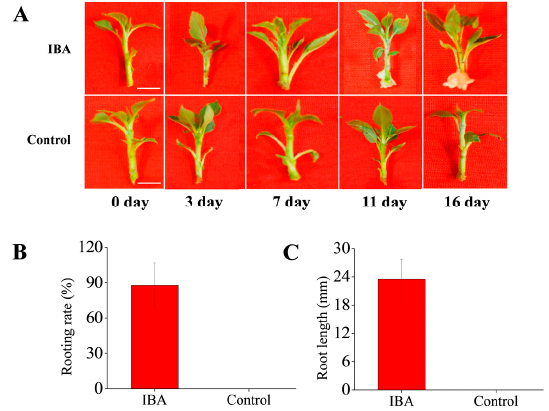
Figure 1. Effects of indole-3-butyric acid (IBA) on adventitious root formation in apple rootstock ‘T337’. ( A ) Morphological changes in ‘T337’ cultural cuttings after treatment with IBA and control for 0, 3, 7, 11, 16 days. Scale bars = 0.5 cm. ( B ) Rooting rate in ‘T337’ with IBA treatment and control at 16 days per 50 cuttings. ( C ) Root length in ‘T337’ with IBA treatment and control at 16 days per 50 cuttings.